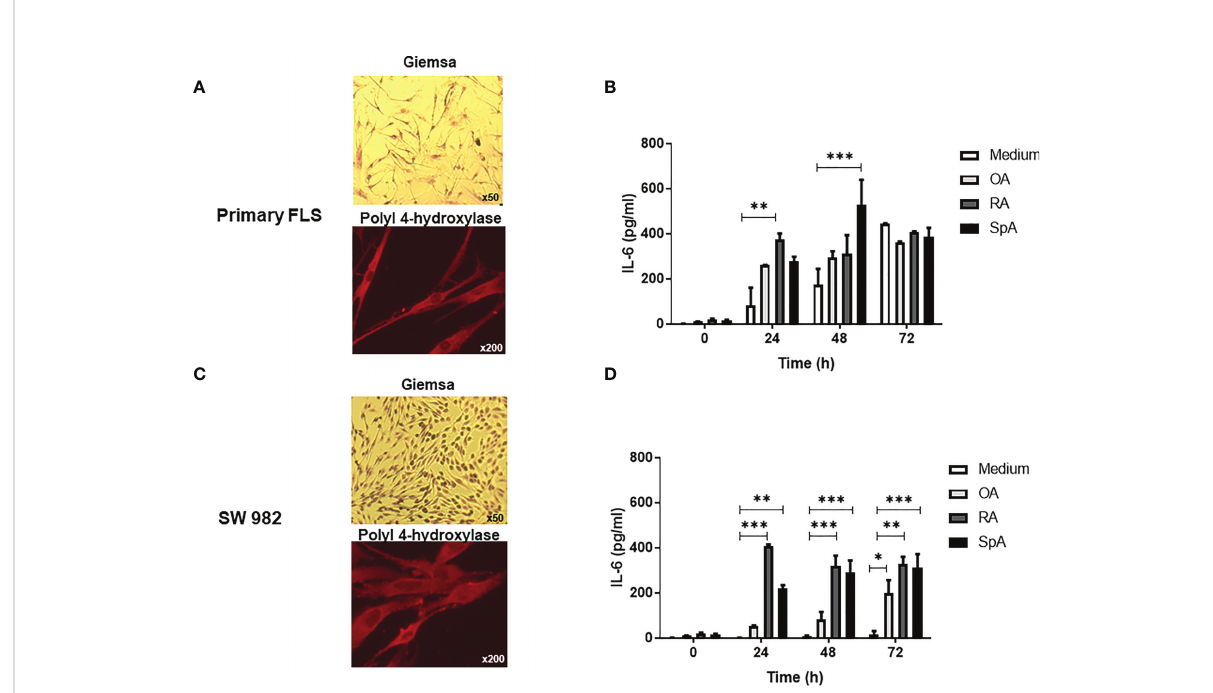
FIGURE 1 IL-6 secretion by primary and SW982 FLS stimulated with peripheral SpA synovial fl uid. Morphology (Giemsa, original magni fi cation x50) and prolyl-4-hydroxylase immunostaining (original magni fi cation x200) of primary (A) or SW982 (C) FLS. IL-6 levels in the supernatants of primary (B) or SW982 (D) FLS incubated with medium, SF pool of OA, RA or peripheral SpA patients. Representative images (A, C) and data (C, D) from three independent experiments are shown. Values are presented as the mean ± SEM. *: p<0.05, **: p<0.01, ***: p<0.001 by the